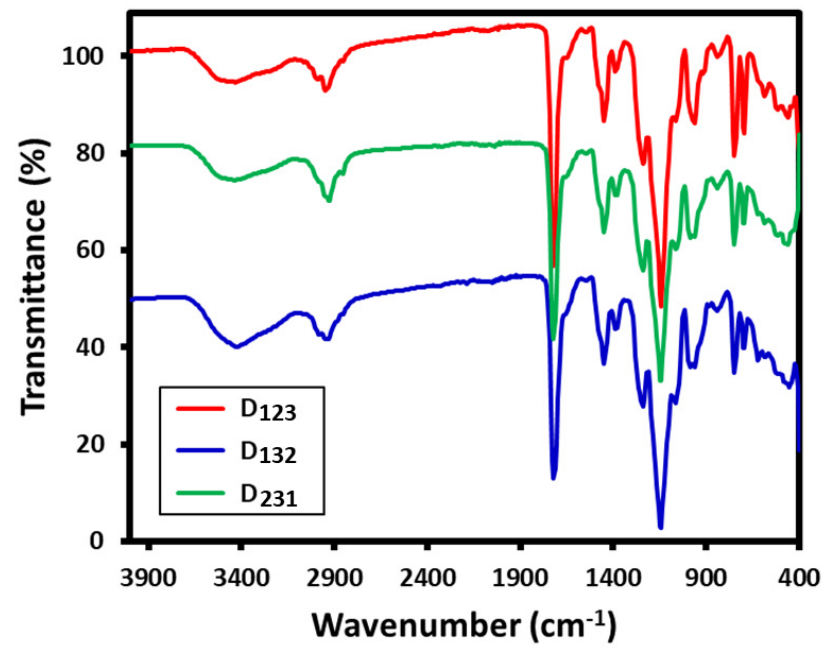
Figure 5. FT-IR spectra of D 123 , D 132 , and D 231 synthesized without BR and BV.